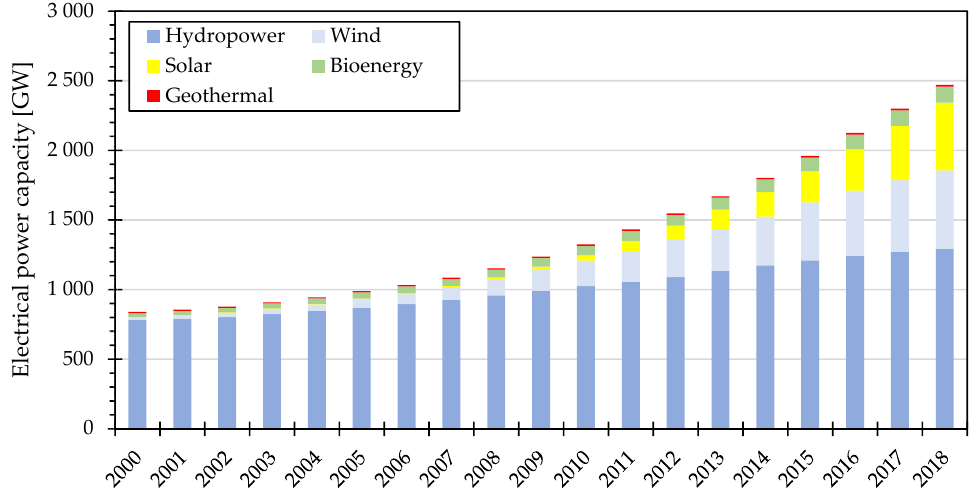
Figure 1. World electricity capacity by renewable energy sources for 2000–2018 (based on data in [5]).